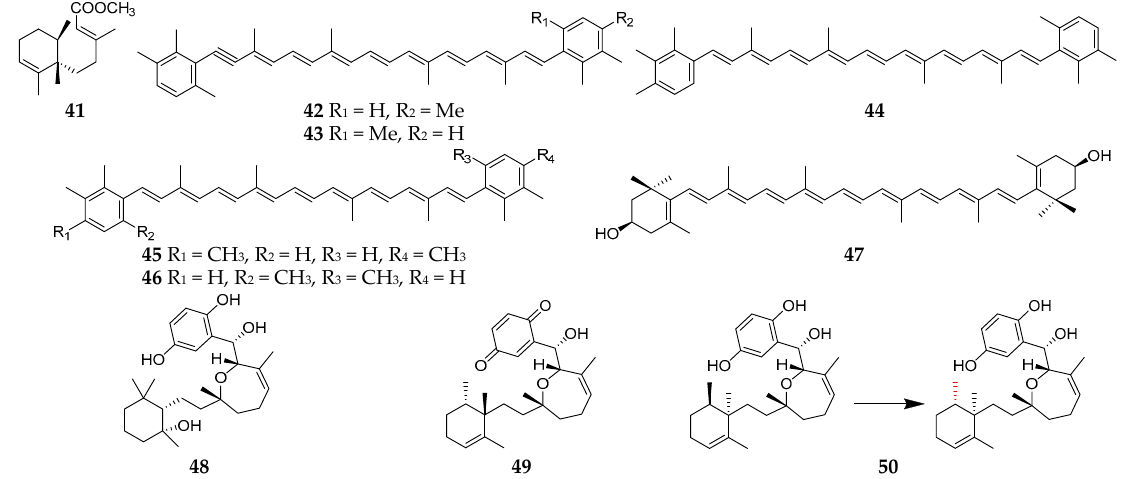
Figure 5. Terpenoids 41 – 50 from the subgenus Reniera.